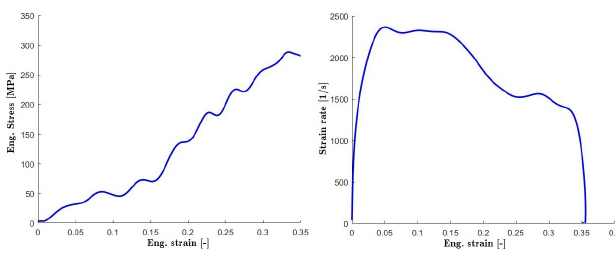
Figure 11. 2D cut missing-rib structure a) stress- strain diagram b) strain rate-strain